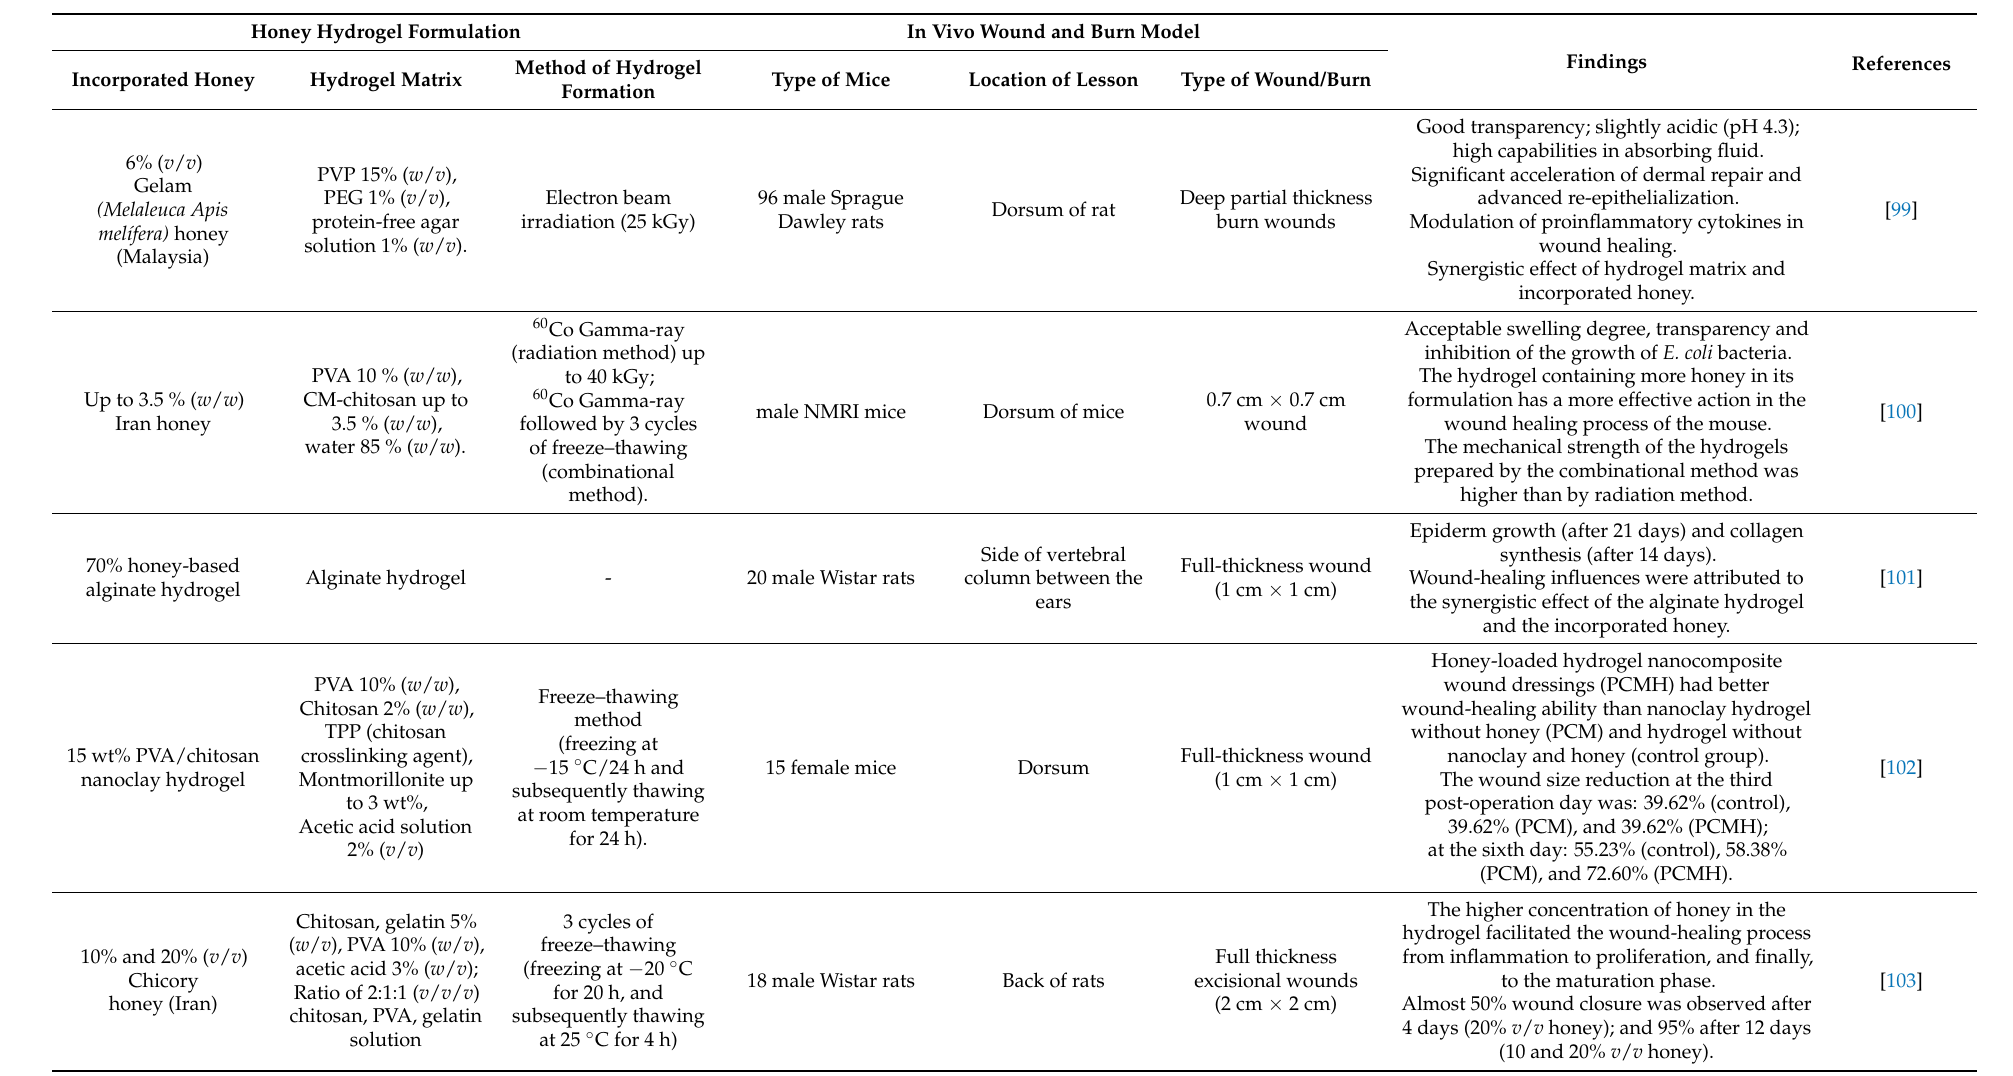
Table 2. Examples of honey hydrogel-based wound dressings, methods of formation, evaluated models and main